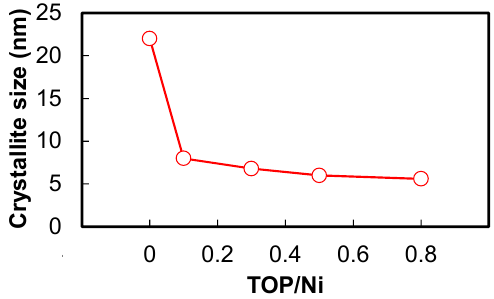
Figure 2. XRD spectra of the Ni nanoparticles at the TOP/Ni ratios in the range of 0–0.8.